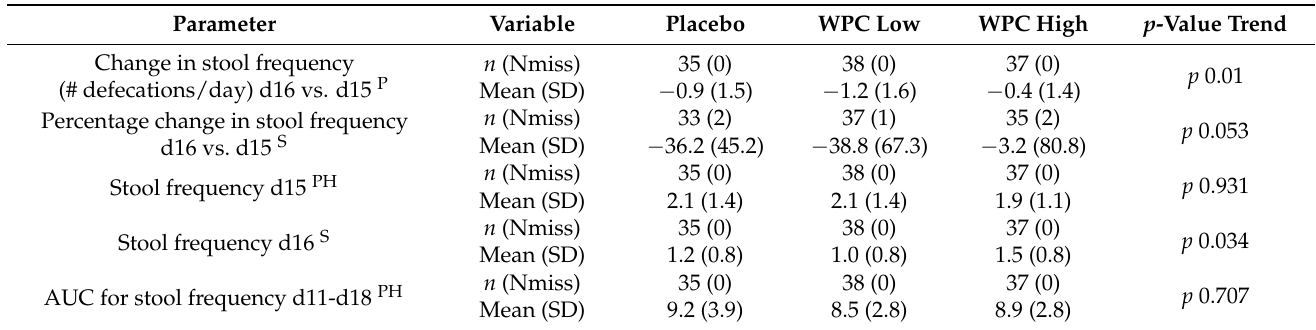
Table 3. Statistical study outcomes in relation to stool frequency.